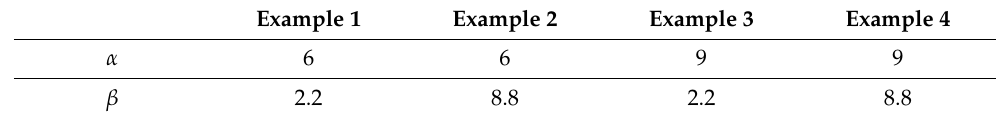
Table 1. α and β values of four examples.